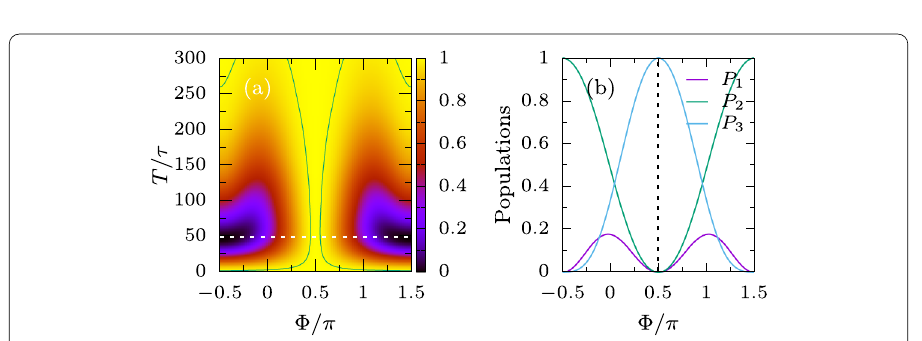
Figure 2 Spatial non-adiabatic passage transport in the 3L approximation. T / τ = 100 for Ω 0 τ = 0.25. (a) Modulus of the tunnelling amplitudes. (b) Evolution of the populations P i = |(cid:10) i | Ψ ( t ) (cid:5)| 2 . The time unit τ is defined as τ = ml 2 / -h .